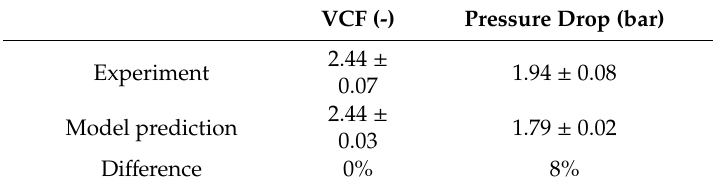
Figure 9. Axial profiles of concentration (blue), concentration at the membrane (orange), flux (black) and transmembrane pressure (red) for experiment and model prediction of the optimized process. Table 4. Comparison of experimental and simulated process variables for the optimized process.